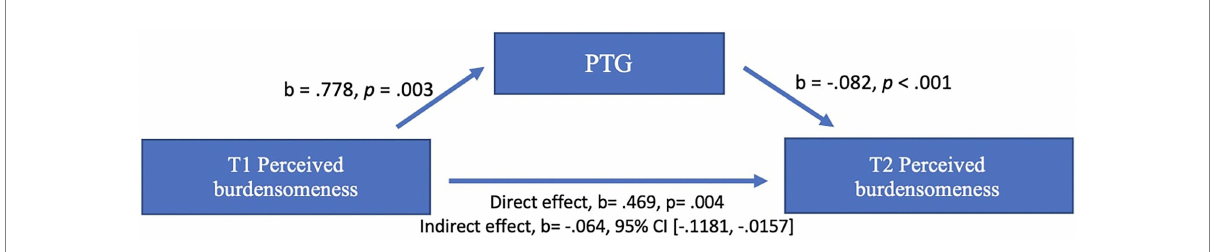
FIGURE 3 PTG mediating the relationship between T1 perceived burdensomeness and T2 perceived burdensomeness. Unstandardised regression coefficient (b) values are reported. Depression and anxiety were controlled in the analysis. The indirect effect is not associated with a p value (see Hayes,